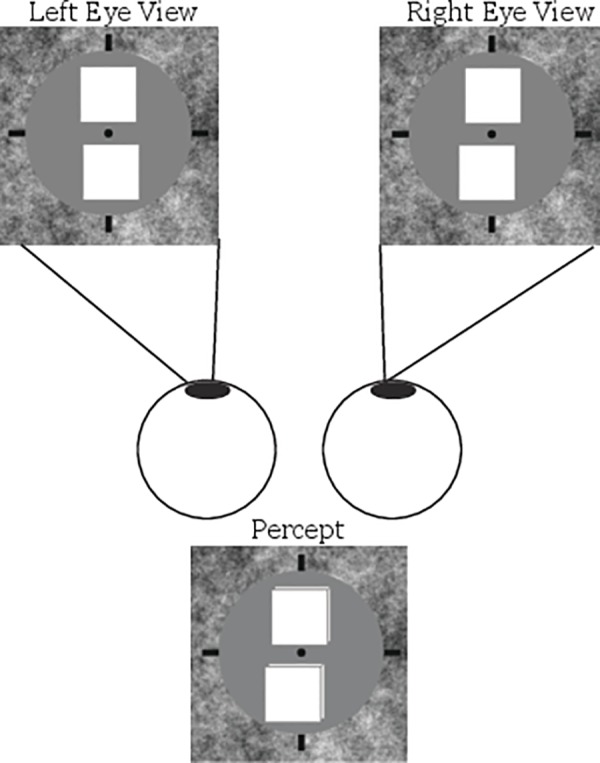
Example display (vertically oriented stimuli).On each trial participants were presented with two white squares offset from one another in both the z- and x-dimensions. Participants performing the vernier acuity task were asked to judge which of the two squares was further to the left, while participants performing the stereo acuity task were asked to judge which of the two squares was closer in depth. Again, note that the actual stimuli were flat squares–they are presented as 3D boxes here for demonstration purposes.